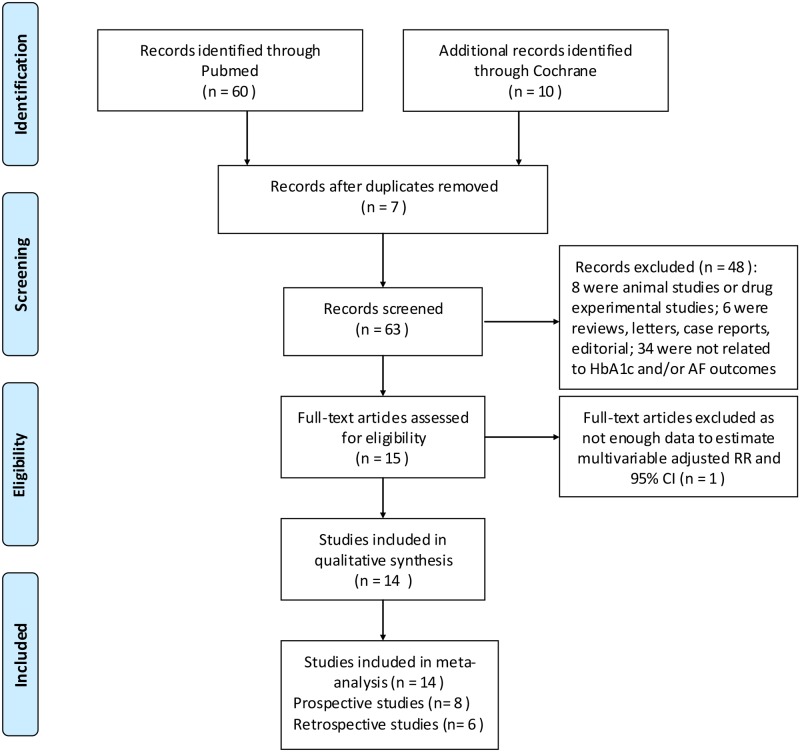
Flow chart of selection of studies for inclusion in meta-analysis.From: Moher D, Liberati A, Tetzlaff J, Altman DG, The PRISMA Group (2009). Preferred Reporting Items for Systematic Reviews and Meta-Analyses: The PRISMA Statement. PLoS Med 6(6): e1000097. doi:10.1371/journal.pmed1000097.